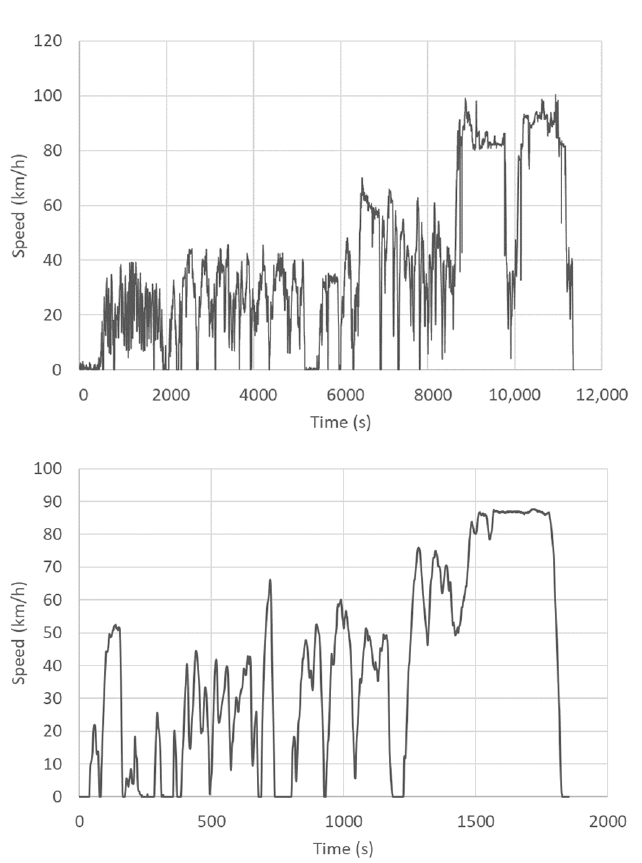
Figure 2. Speed profile of the on-road tests ( top panel ) and WHVC test ( bottom panel ).